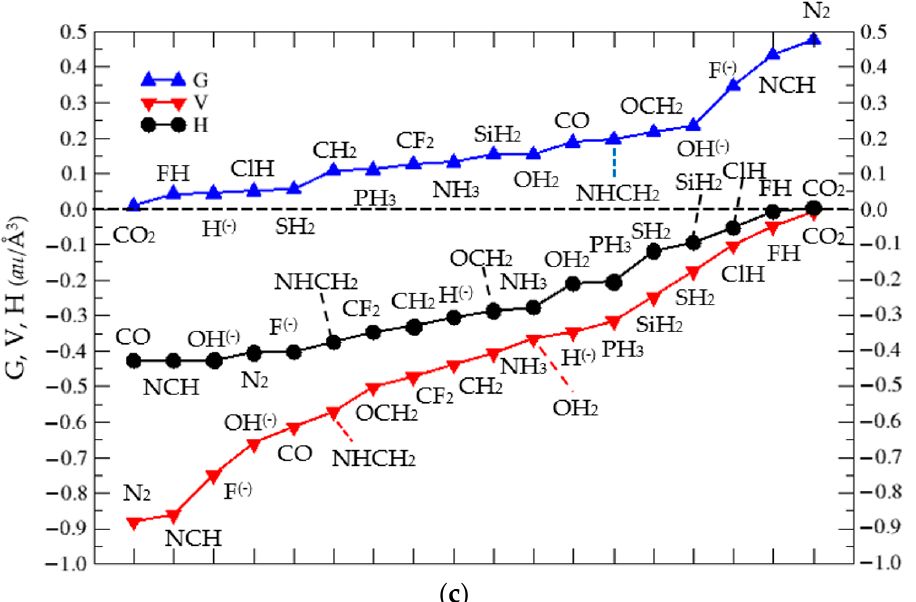
Figure 6. ( a ) . ρ ( r ) at the BCP of the C ⋯ X interaction in complexes ( 1 : n ) vs. d (CX), with n = 2 – 19 . We label each point with the corresponding LB. ( b ) ∇ 2 ρ ( r ) at the C ⋯ X BCP for complexes ( 1 : n ), n = 2 – 19 . ( c ) Plot of G ( ), V ( ), and H ( • ) vs. Lewis base LB( n ) in increasing order of G, V, and H, respectively, at the Bond Critical Point (BCP) in the C ⋯ X interaction of complexes ( 1 : n ), n = 2 – 19 , as described in Scheme 1.